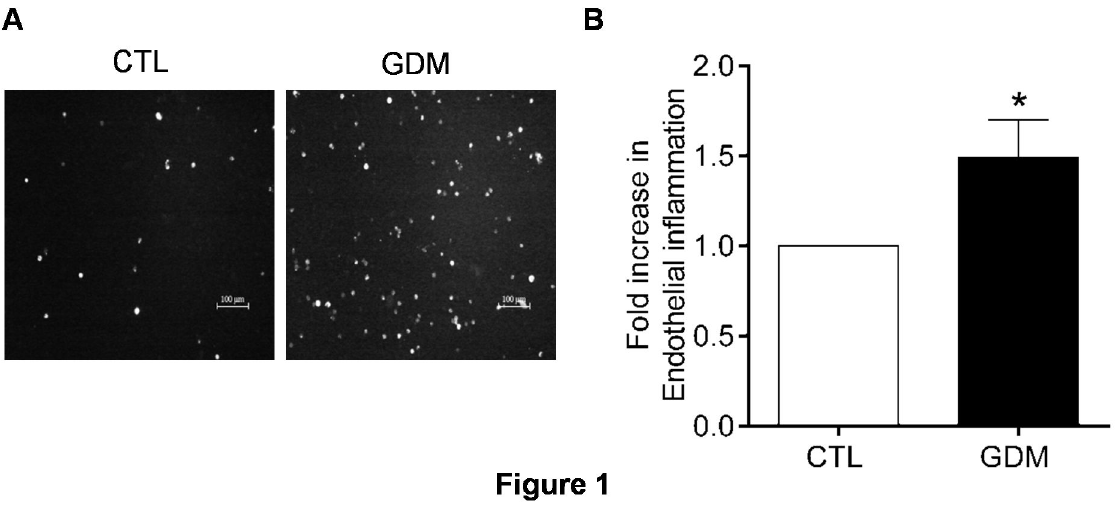
Figure 1. Subclinical inflammation in HUVECs isolated from GDM women. (A) Representative picture depicting adherence of PKH26 labelled leukocytes to human umbilical vein–derived endothelial cell (HUVEC) monolayer of control and GDM subjects. (B) Bar graph summarizing fold increase in adhesion of leukocytes to HUVECs for a minimum of 10 subjects in each group. Inflammation was scored as number of leukocytes adhered per field view. *p≤0.05 represents statistical significance versus control. doi: